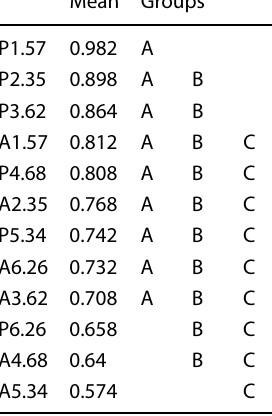
Table 20 The grouping letter table of the Tukey